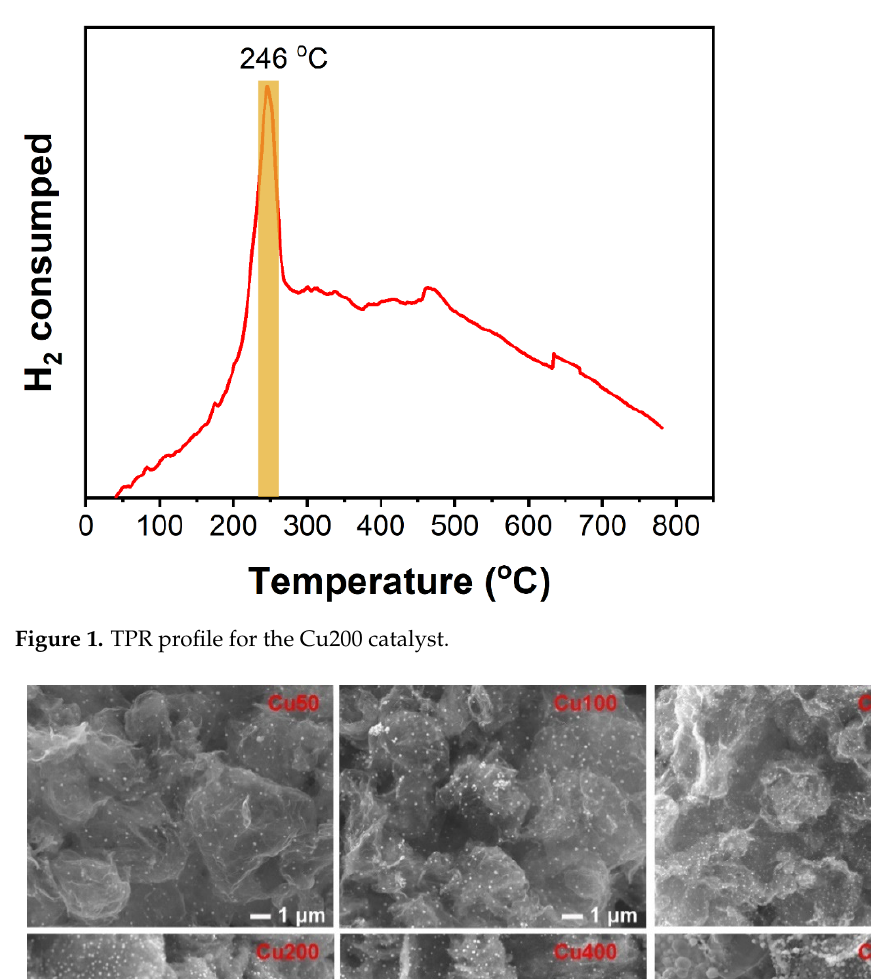
Figure 1. TPR profile for the Cu200 catalyst.